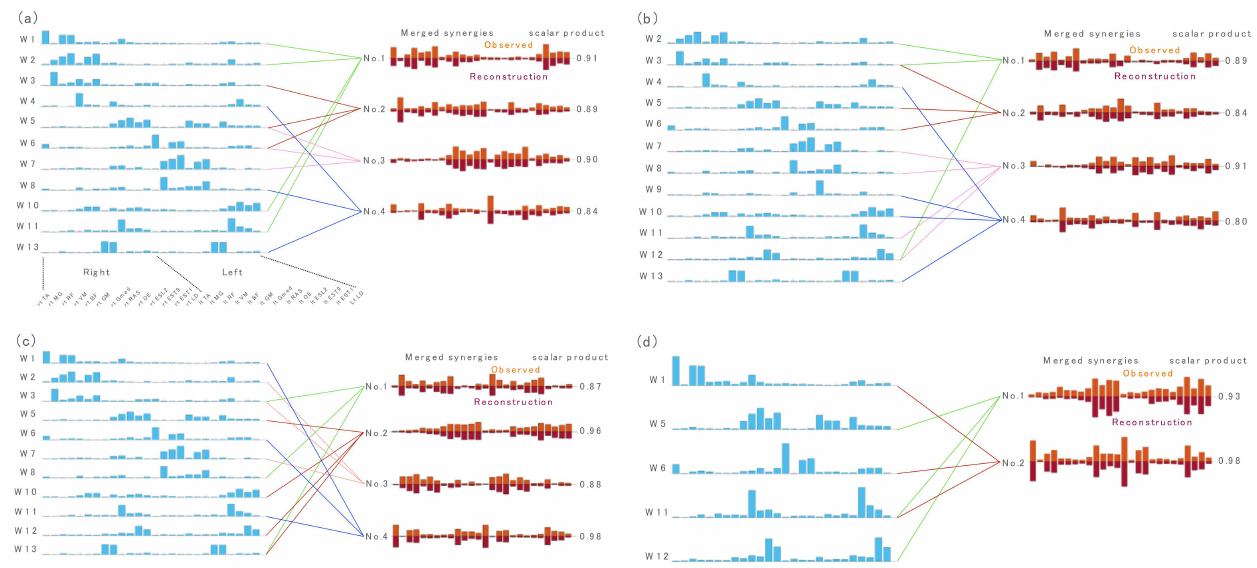
Figure 2. The relationship between muscle synergies of all tasks and muscle synergies of locomotion tasks including ( a ) walk, ( b ) run, ( c ) bilateral jump and ( d ) sit-to-stand-to-sit. The figures show the synergy cluster centroids of these tasks that could be explained by either a single or linearly combined multiple synergy cluster centroids of all tasks (synergies in blue) matched by maximizing scalar product > 0.75. Observed muscle synergies extracted from the single-task EMG (orange) and their reconstructions by merging their respective W1-combinations (dark orange) are further presented. The relationships between muscle synergies from the all-task EMG matrices and those from the other single-task EMG matrices are shown in Figures S1 and